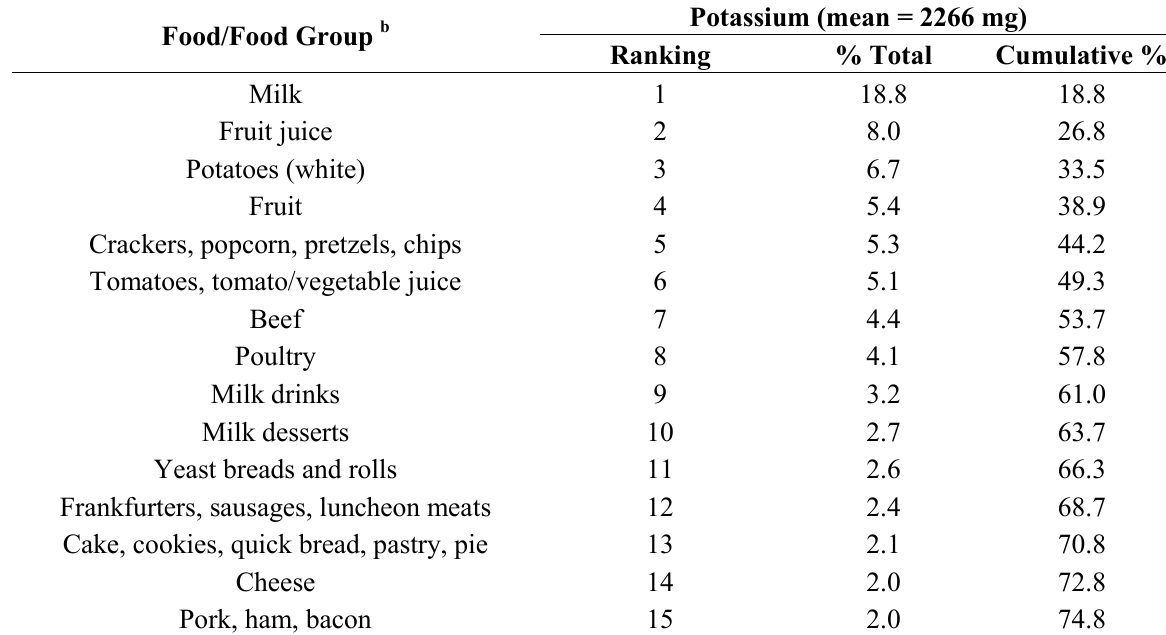
Table 12. Food/Food group sources of potassium among US children aged 2–18 years (from NHANES 2003–2006) a